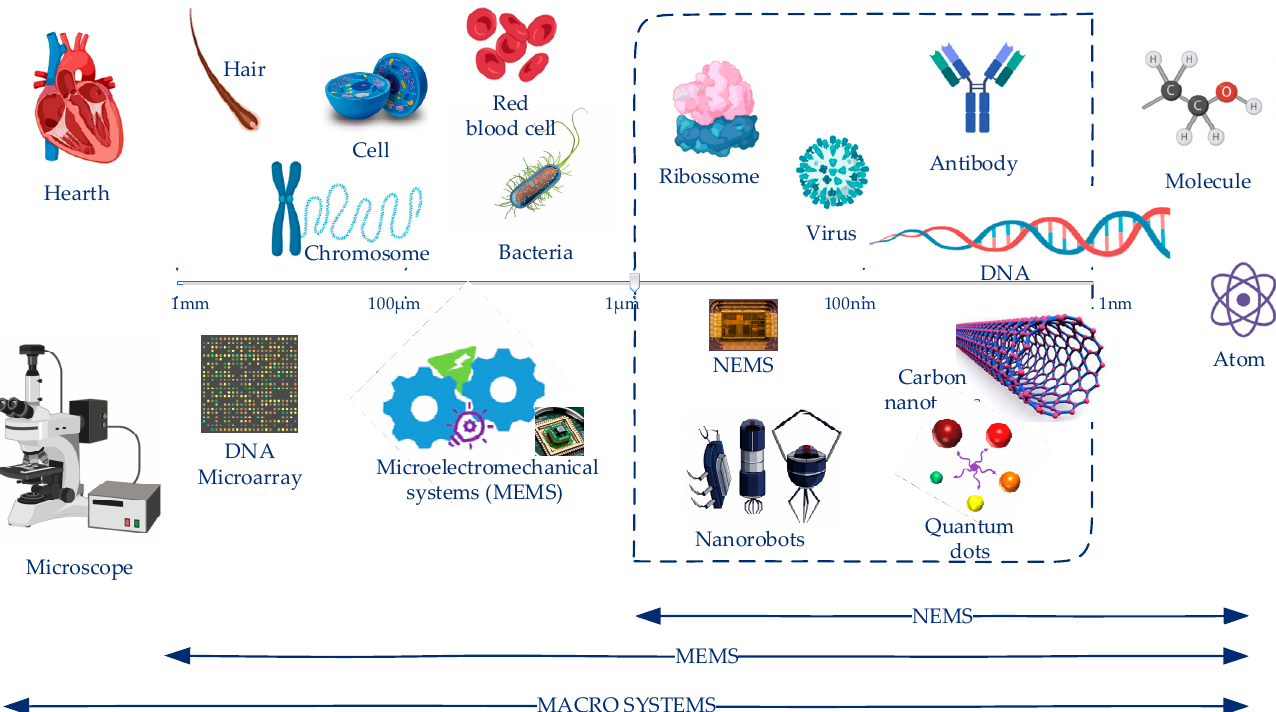
Figure 1. Scales in nature, ranging from micro-systems to nano-systems.